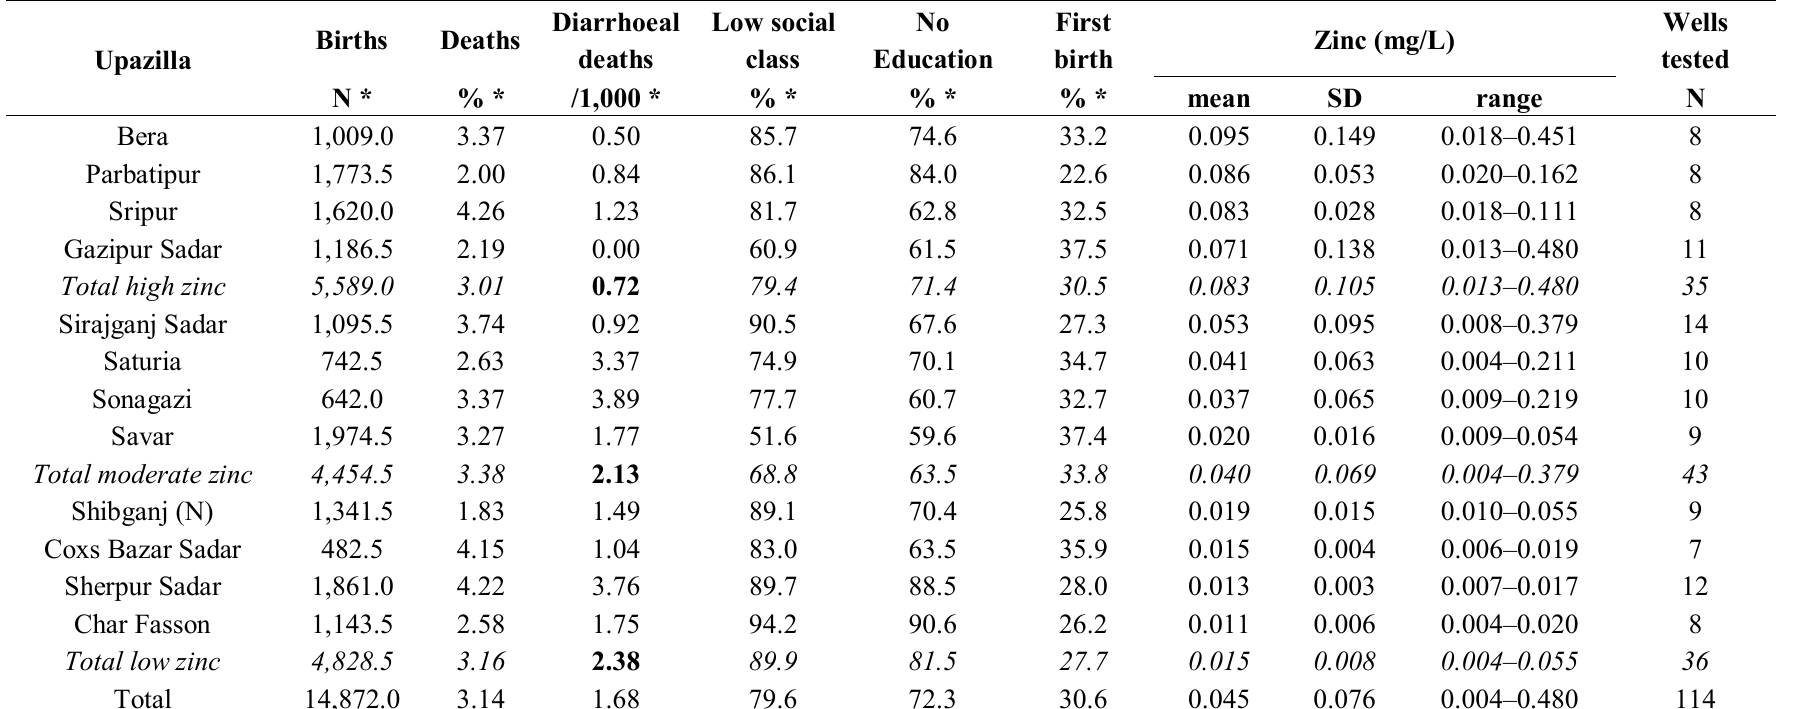
Table 1. Description of the upazillas included in the